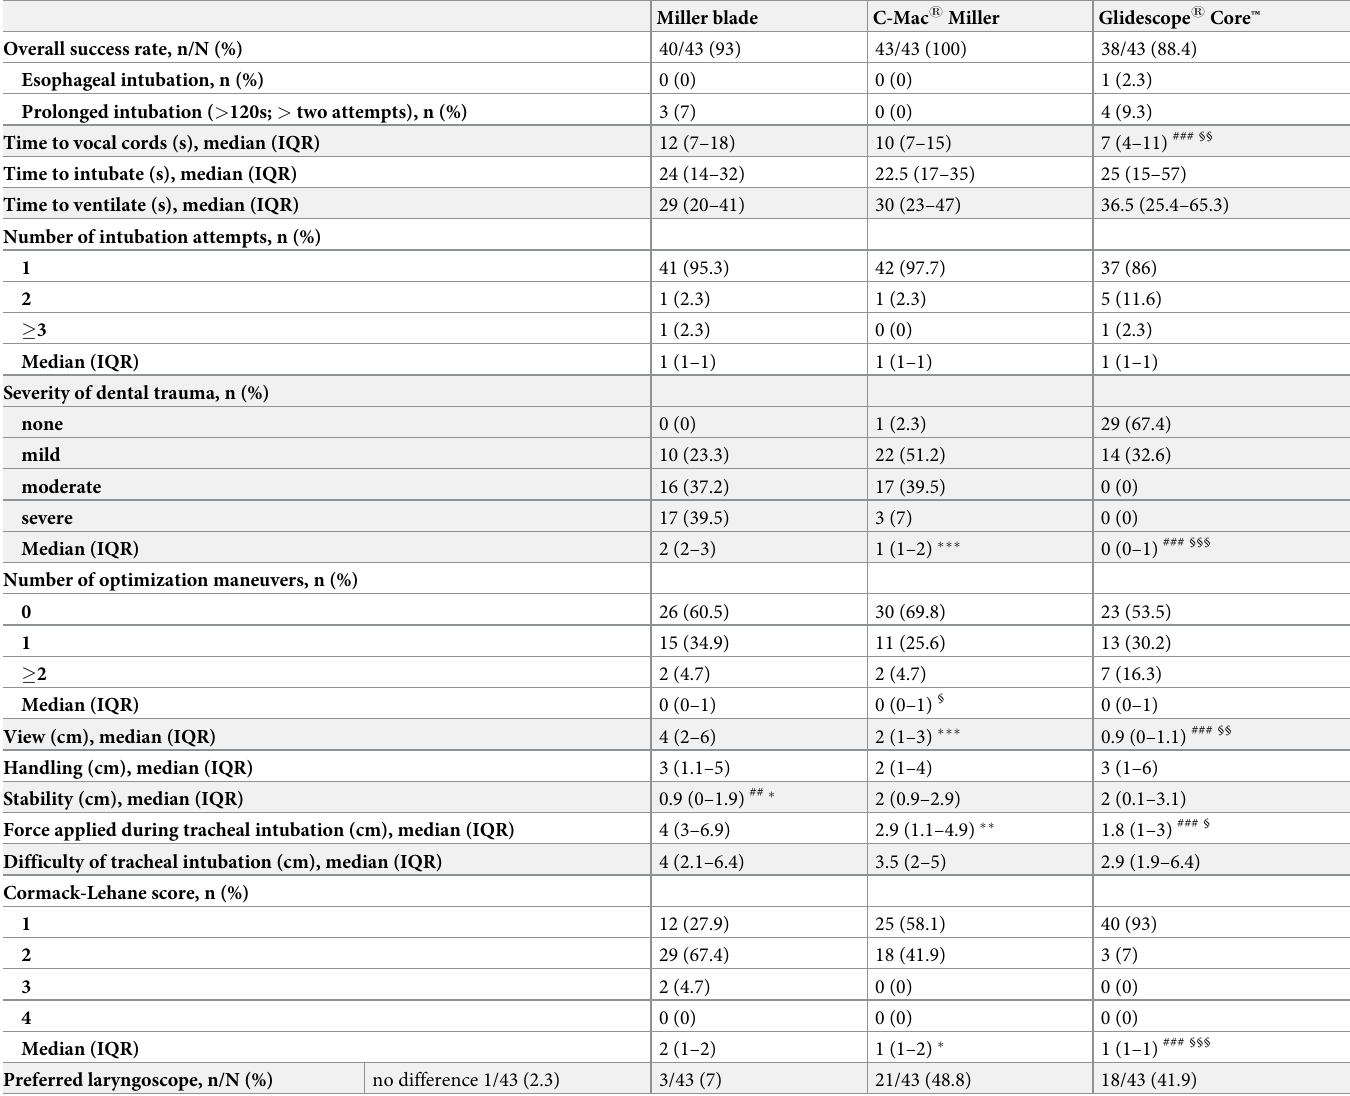
Table 2. Intubation data of the anesthetists with limited previous